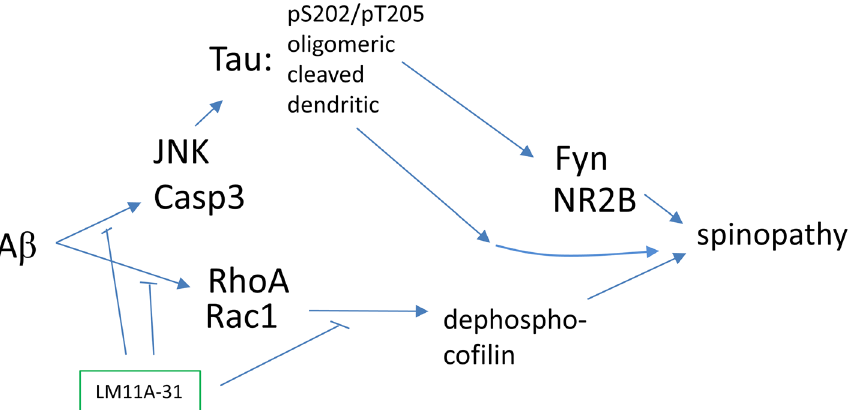
Figure 7. Model for LM11A-31/p75 modulation of Aβ-induced degenerative signaling. p75 signaling intersects several potentially degenerative Aβ-induced signaling pathways including those involving JNK, caspases and RhoA and that enhance formation of potentially toxic modified forms of tau. The present study points to regulation of tau phosphorylation and RhoA activation as two mechanisms promoted by modulation of p75 signaling likely to contribute to resilience of spine degeneration induced by